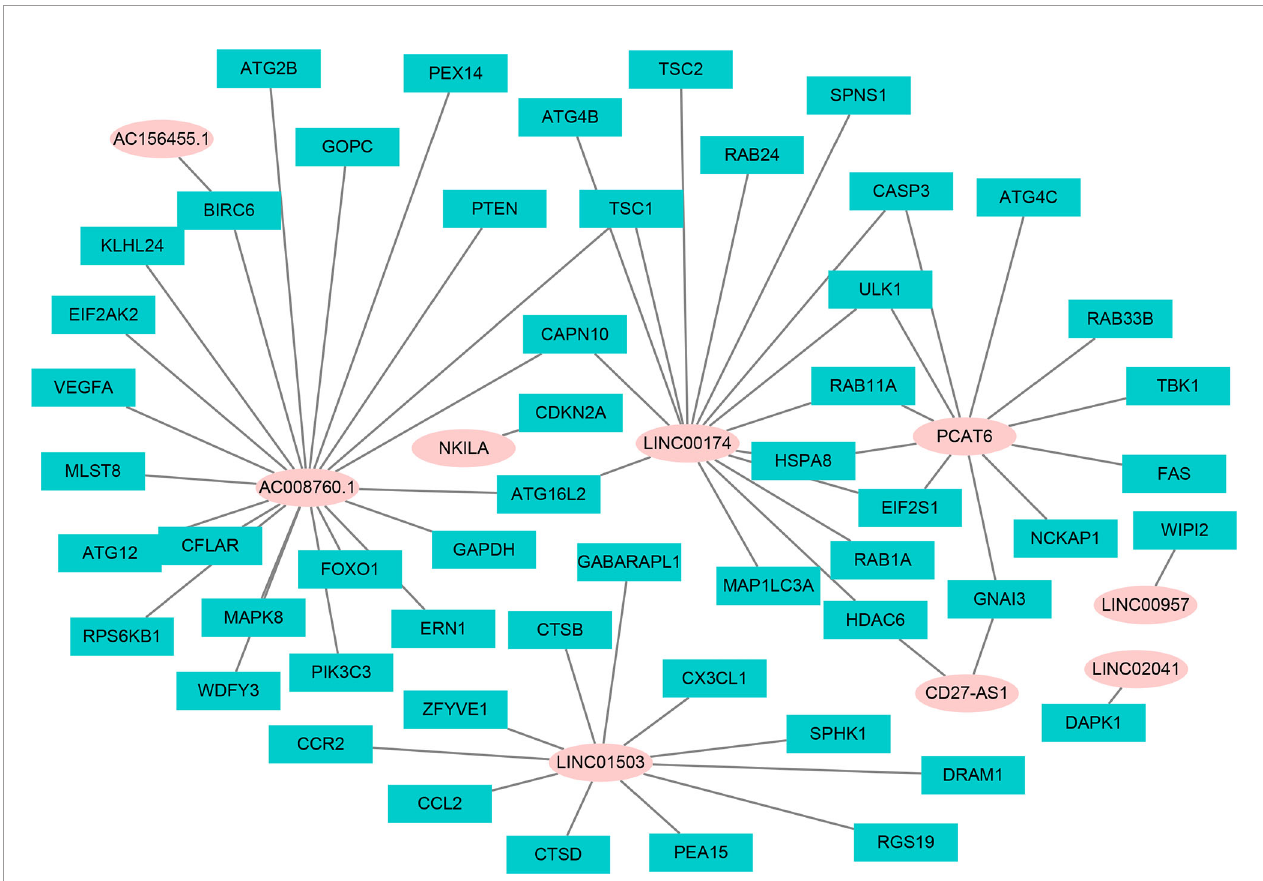
FIGURE 2 | The interaction network of OS-associated lncRNAs and autophagy genes. The pink circle refers to ARlncRNA, and the cyan square refers to autophagy